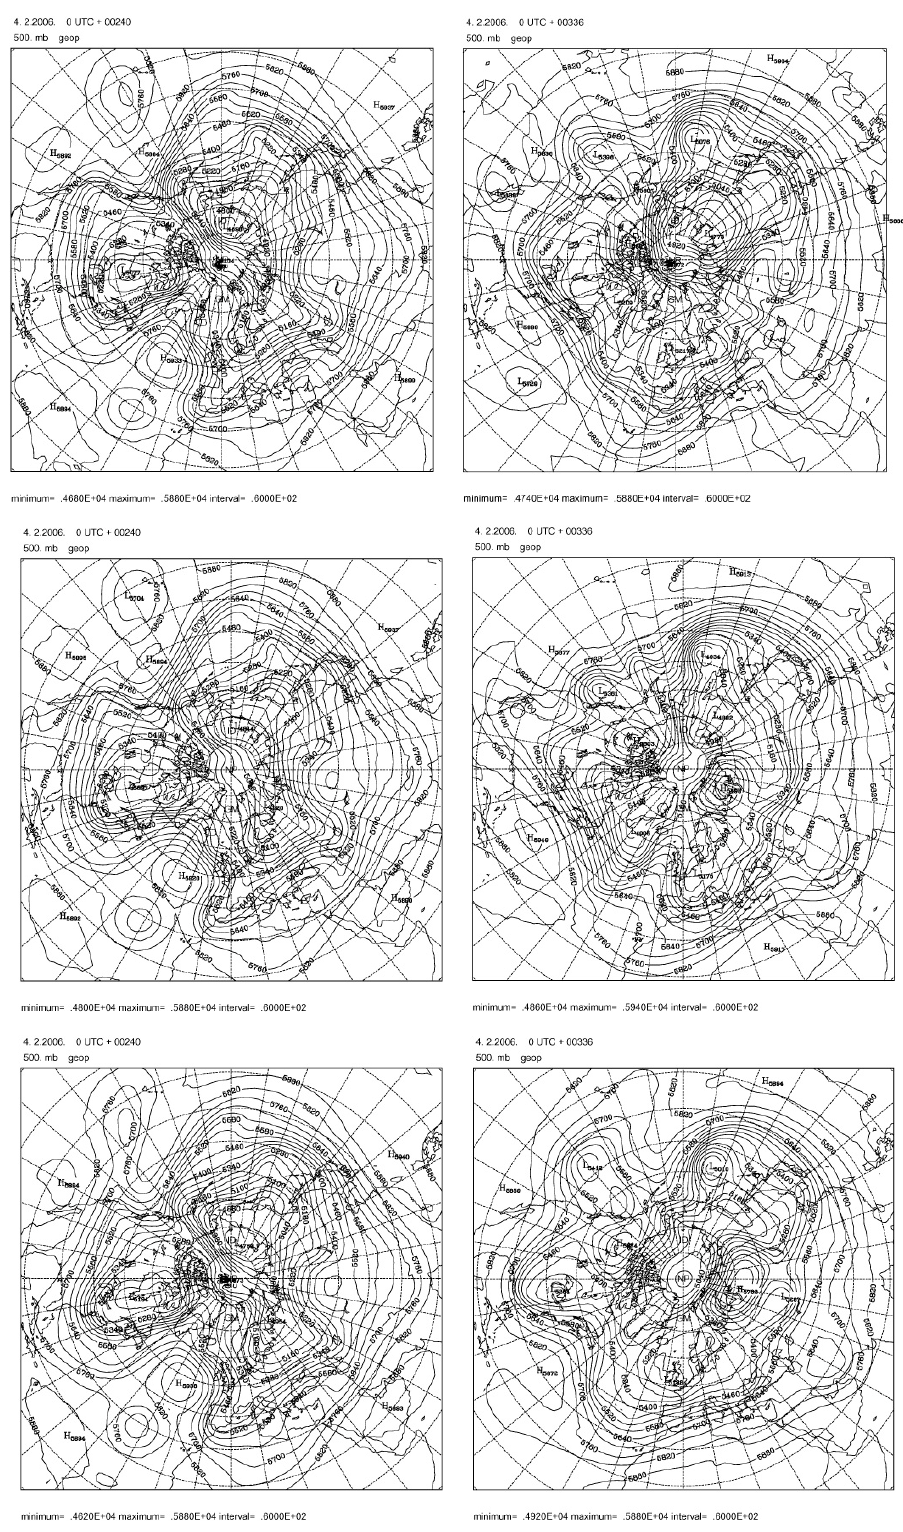
Figure 2. 10-day forecasts (left) and 14-days forecasts (right) of 500hPa geopotential for g = 9.8060226ms − 2 (top), g = 9.8060326ms − 2 (middle) and g = 9.7960226ms − 2